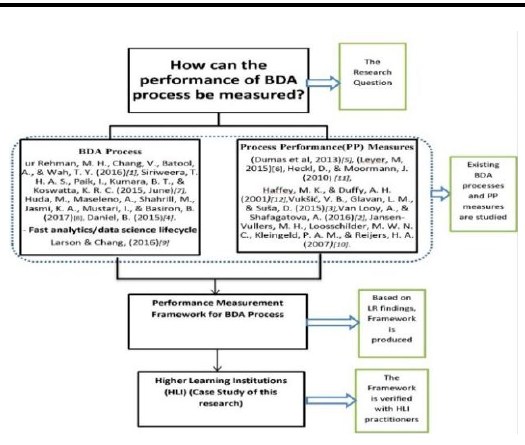
Figure 1 : The Research Structure